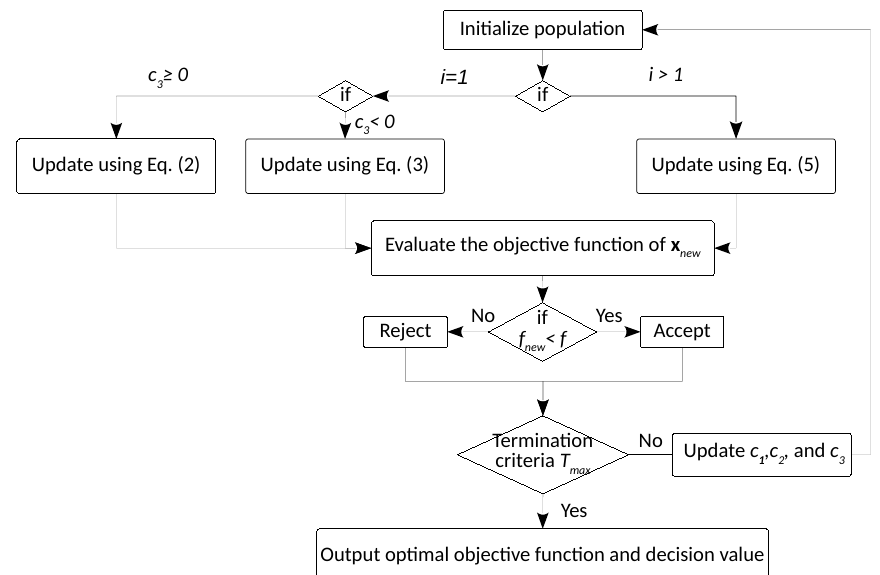
Figure 1. Block diagram of the